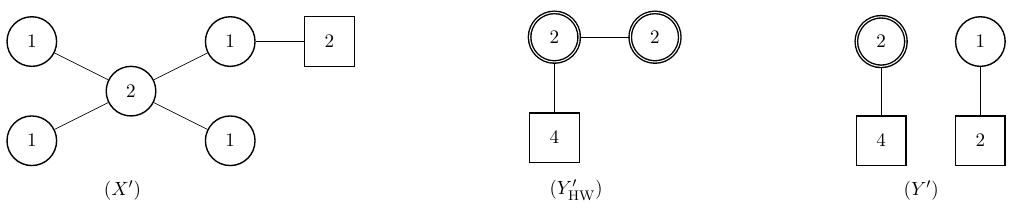
Figure 62 . The Hanany-Witten dual of the theory X 0 and the good dual. The former is a bad theory since the SU(2) node without fundamental hypers is a bad